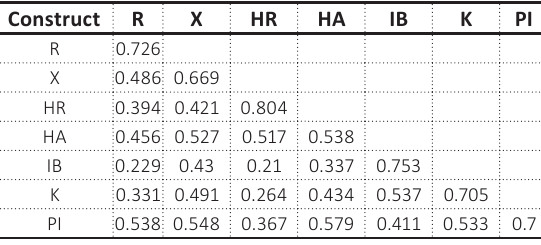
Table 3. Discriminant validity